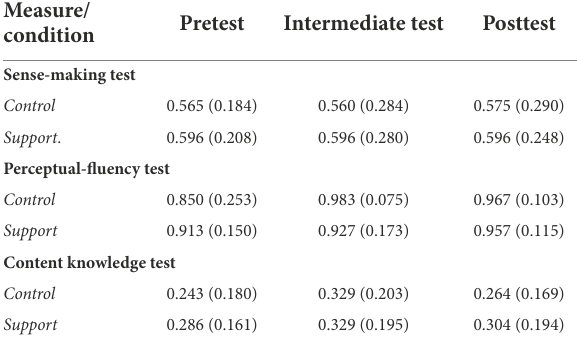
TABLE 1 Means (standard errors) for each test by measure, condition, and test time. All measures are on a scale from 0 to